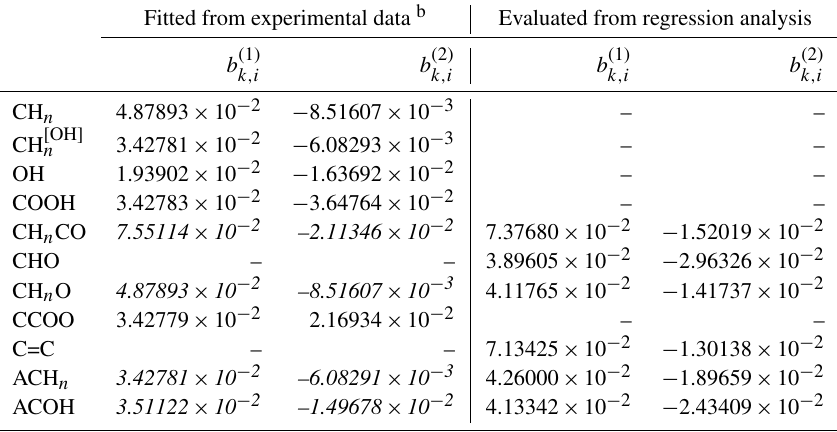
Table 9. Determined middle-range interaction parameters b (1) values were either determined from a AIOMFAC model fit to experimental data or by using a regression method to predict the values based on the known parameters of other ions interacting with the listed organic main groups a